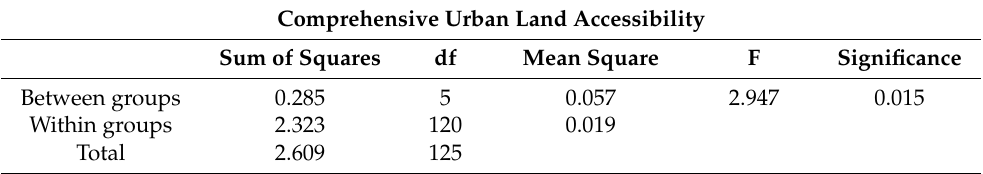
Table 9. Variance analysis of comprehensive accessibility of educational facilities by category.